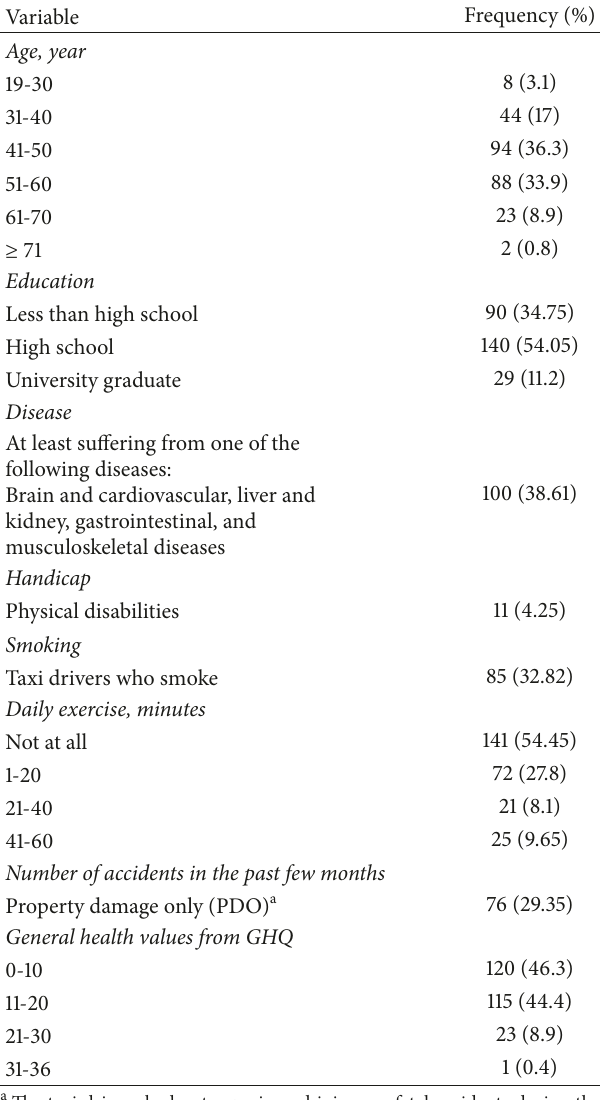
Table 2: Demographic variables